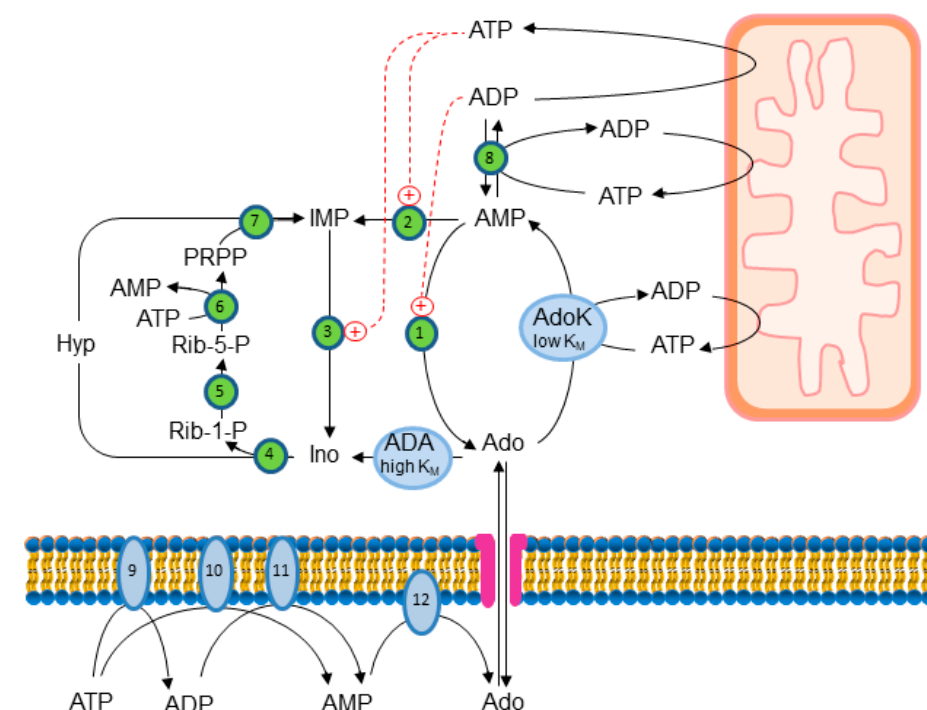
Figure 1. Interplay between internal and external Ado production. Ado originates intracellularly from AMP predominantly in case of low energy charge, and can be exported or deaminated. Extracellular Ado stemming from ATP breakdown may enter the cell and is readily phosphorylated by the low K M adenosine kinase (AdoK). The high K M adenosine deaminase (ADA) comes into play if Ado accumulates. 1: cytosolic 5 ′ -nucleotidase I (cN-I); 2: AMP deaminase; 3: cytosolic 5 ′ -nucleotidase II (cN-II); 4: purine nucleoside phosphorylase (PNP); 5: phosphoribomutase; 6: PRPP synthetase; 7: hypoxanthine guanine phosphoribosyltransferase (HPRT); 8: adenylate kinase; 9,11: ecto-nucleoside triphosphate diphosphohydrolase; 9: ecto-nucleotide pyrophosphatase/phosphodiesterase; 12: ecto-5 ′ -nucleotidase.